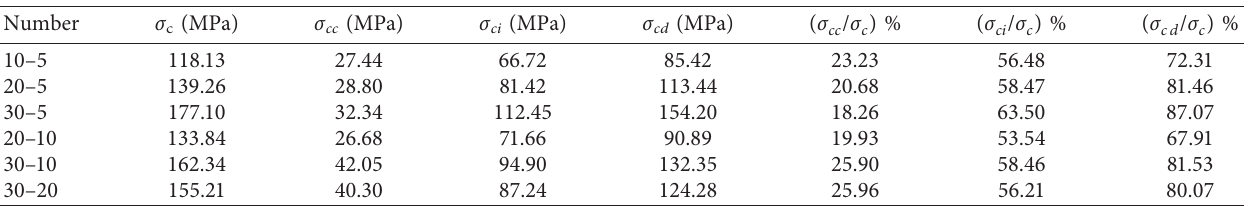
Figure 8: Variation of volumetric strain of different pore water cracks. Table 2: Characteristic stress data table.